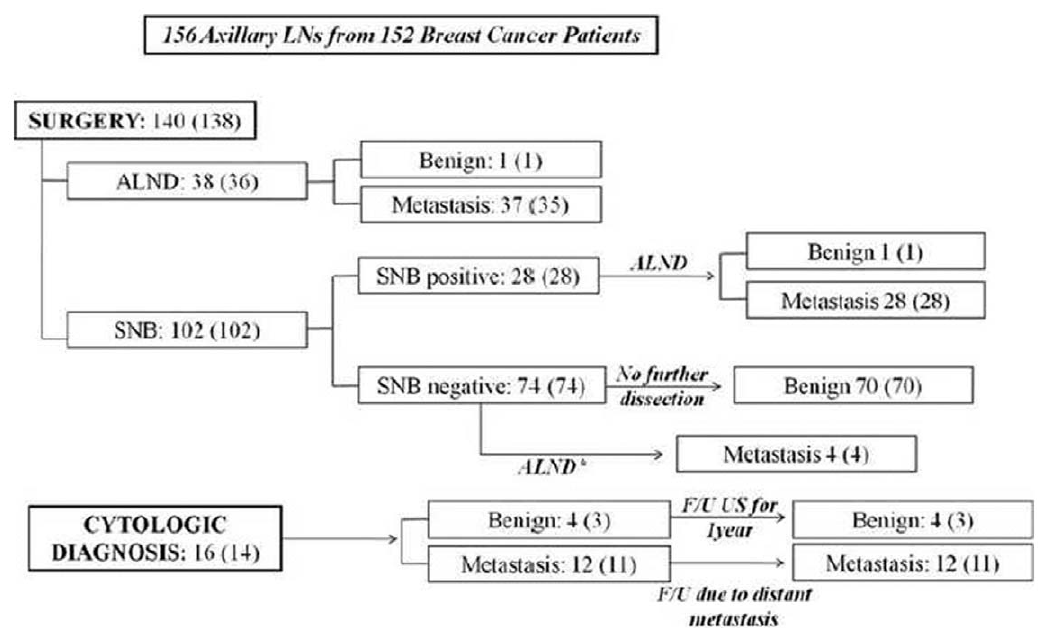
Figure 1. Diagram of diagnosis, surgical management and pathologic diagnosis of the axillary LNs in 152 patients with breast cancer. Note: patient numbers are in parentheses ALND: axillary lymph node dissection. * : ALND performed due to metastatic results on preoperative US-FNAB cytology, All 4 patients had received neoadjuvant chemotherapy, and final pathology showed micrometastatic foci within the lymph nodes.